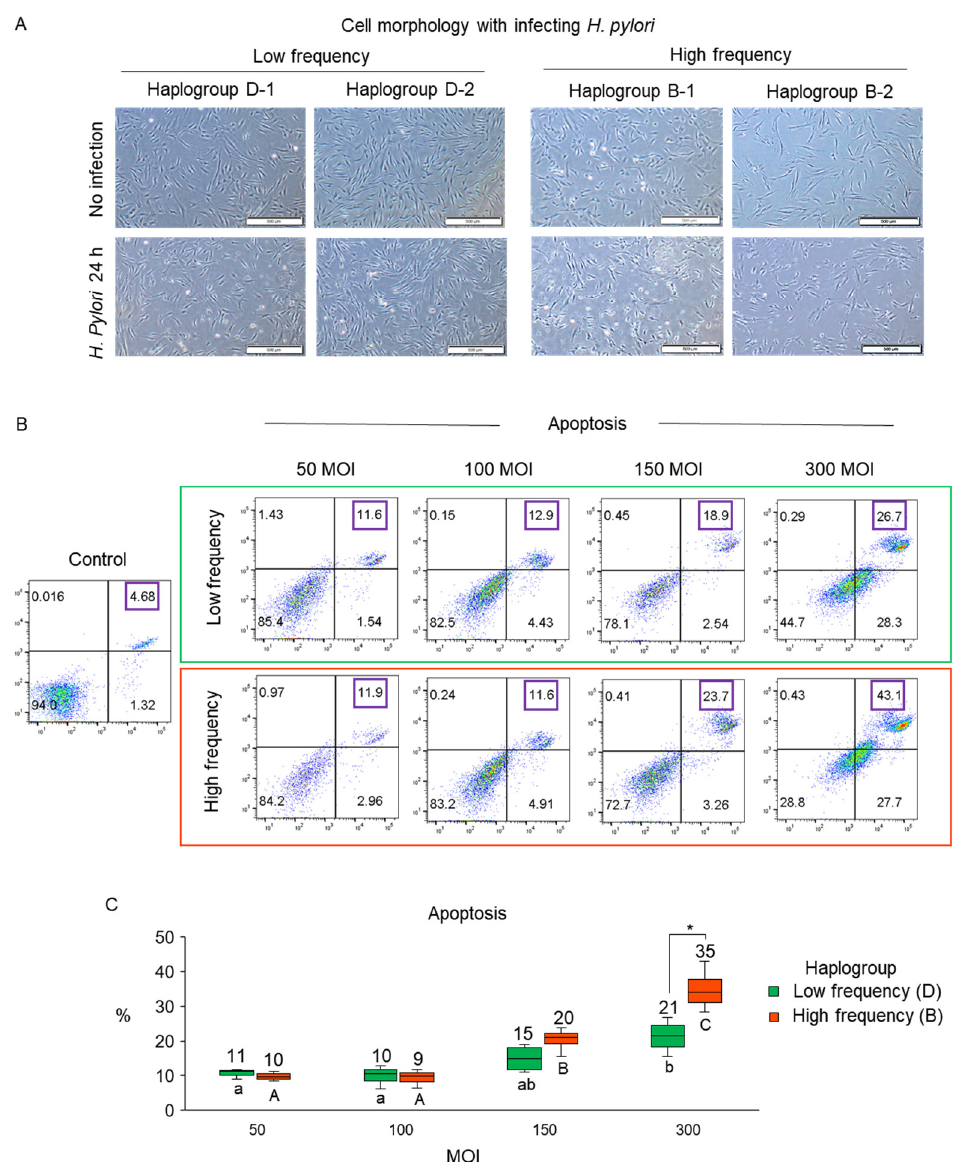
Figure 3. Different apoptosis rates upon H. pylori infection depending on mtDNA haplogroups. ( A ) Different cell morphology before and after H. pylori infection depending on the mtDNA haplogroup. High-frequency haplogroup showed shrinkage-like morphology. Scale bar: 500 µ m. ( B ) Apoptosis rates in low- and high-frequency haplogroups with H. pylori infection at various MOI. Purple boxes indicate apoptotic rate. ( C ) Increased apoptosis in high-frequency haplogroup upon H. pylori infection at high MOI. Letters a and b indicate significant differences among different MOI treatments in low-frequency haplogroup ( p < 0.05). Letter A, B, and C indicate significant differences among different MOI treatments in high-frequency haplogroup ( p < 0.05). * indicates a significant difference between low and high-frequency haplogroup at 300 MOI ( p < 0.05).